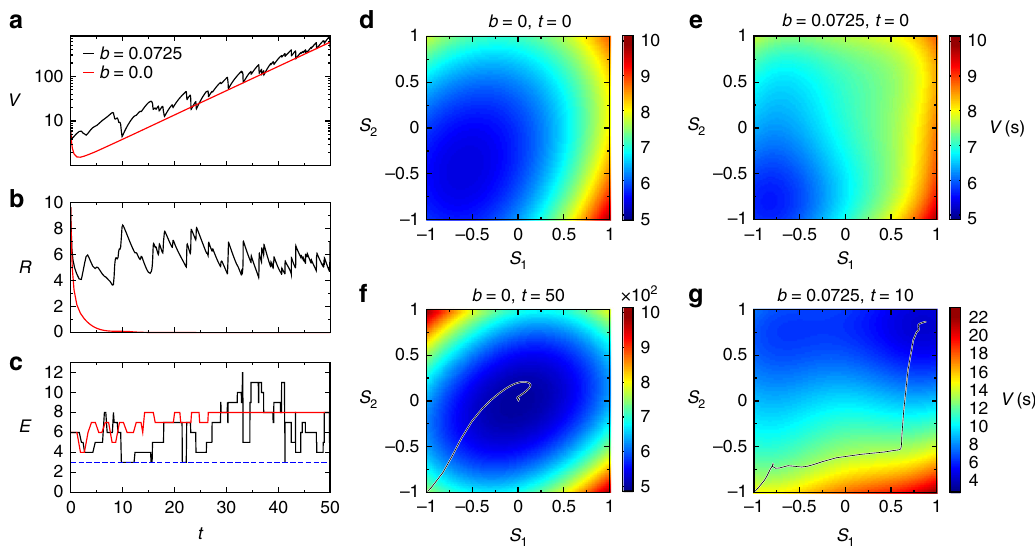
q ffiffiffiffiffiffiffiffiffiffiffiffi P Fig. 1 MaxSAT solver dynamics. The Max 3-SAT formula used here has N = 10, M = 80 (clauses given in the Supplementary Data 1). a The potential V , b s 2 , and c the number of unsatis fi ed clauses (energy) E as function of analog time t for the original dynamics corresponding to b = 0 the radius R ¼ i i (red) and the modi fi ed dynamics with b = 0.0725 (black). d – g Colormaps of the potential V ( s ( t ), a ( t )) in the plane ( s 1 , s 2 ). At a given time instant t we fi x all values s j ( t ), j = 3, … , N and a m ( t ), ∀ m and change only s 1 , s 2 in the [ − 1, 1] × [ − 1, 1] plane, showing the instantaneous potential energy landscape V in this plane. The curves indicate the projection of the trajectory onto ( s 1 , s 2 ) up to the indicated time t . In t = 0, s 1 = s 2 = − 1. For b = 0, the dynamics converges to s = 0, which is the centre of a deep well in the potential landscape. For b = 0.0725, the centre is not a minimum anymore and at time t = 10 the orthant with minimal energy E min = 3 is found (the solution), shown as a blue dotted line in the E ( t ) fi